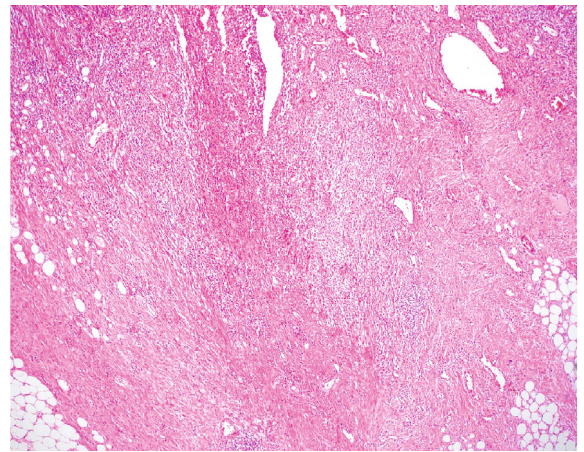
Figure 2: H&E demonstrating fi ssuring ulcer (tumor not in view) at 40 magni fi cation